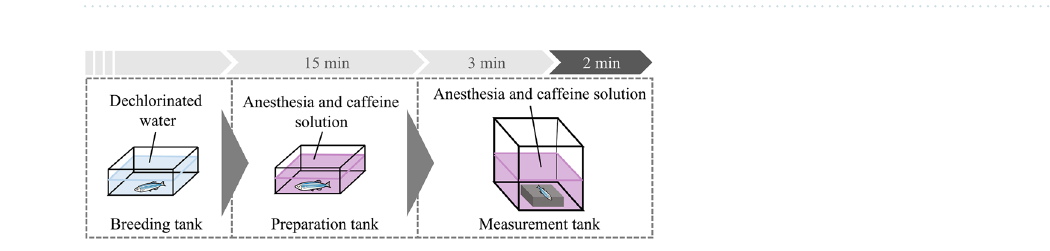
Figure 3. Measurement equipment for experiment under restraint conditions. ( a ) Schematic diagram of measurement and analysis units. ( b ) Region of interest (ROI) around the gill. ( c ) Electrode insertion into the fish.